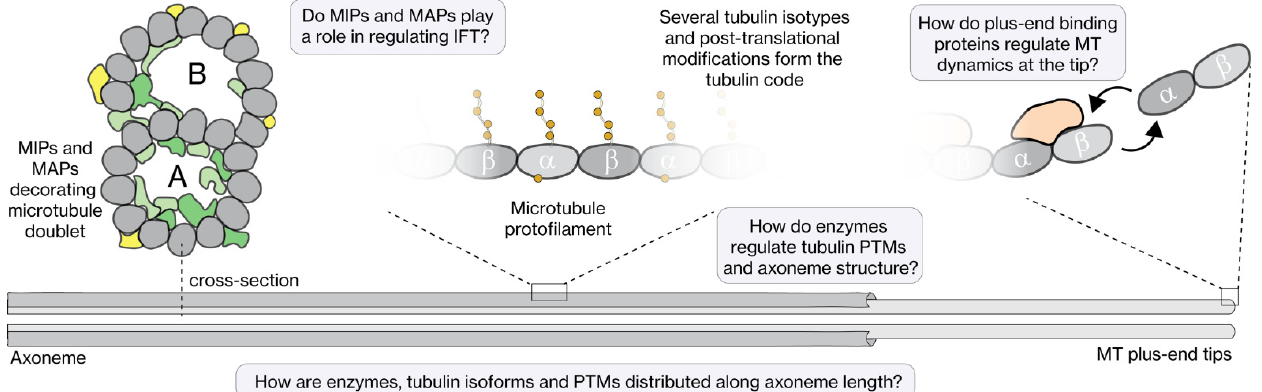
Figure 3. The axoneme track and its regulators. The MTs (A-tubule and B-tubule) that make up the axoneme structure are heavily decorated with MIPs and MAPs, which potentially play a role in regulating IFT. The tubulin lattice itself is composed of several tubulin isotypes that have several post-translational modifications (acetylation, glutamylation, detyrosination, etc.), which form the tubulin code. How regulating enzymes modulate the tubulin code and axoneme structure, how the tubulin code influences IFT, and how dynamics of the MT tips are regulated, are still open questions in the field.